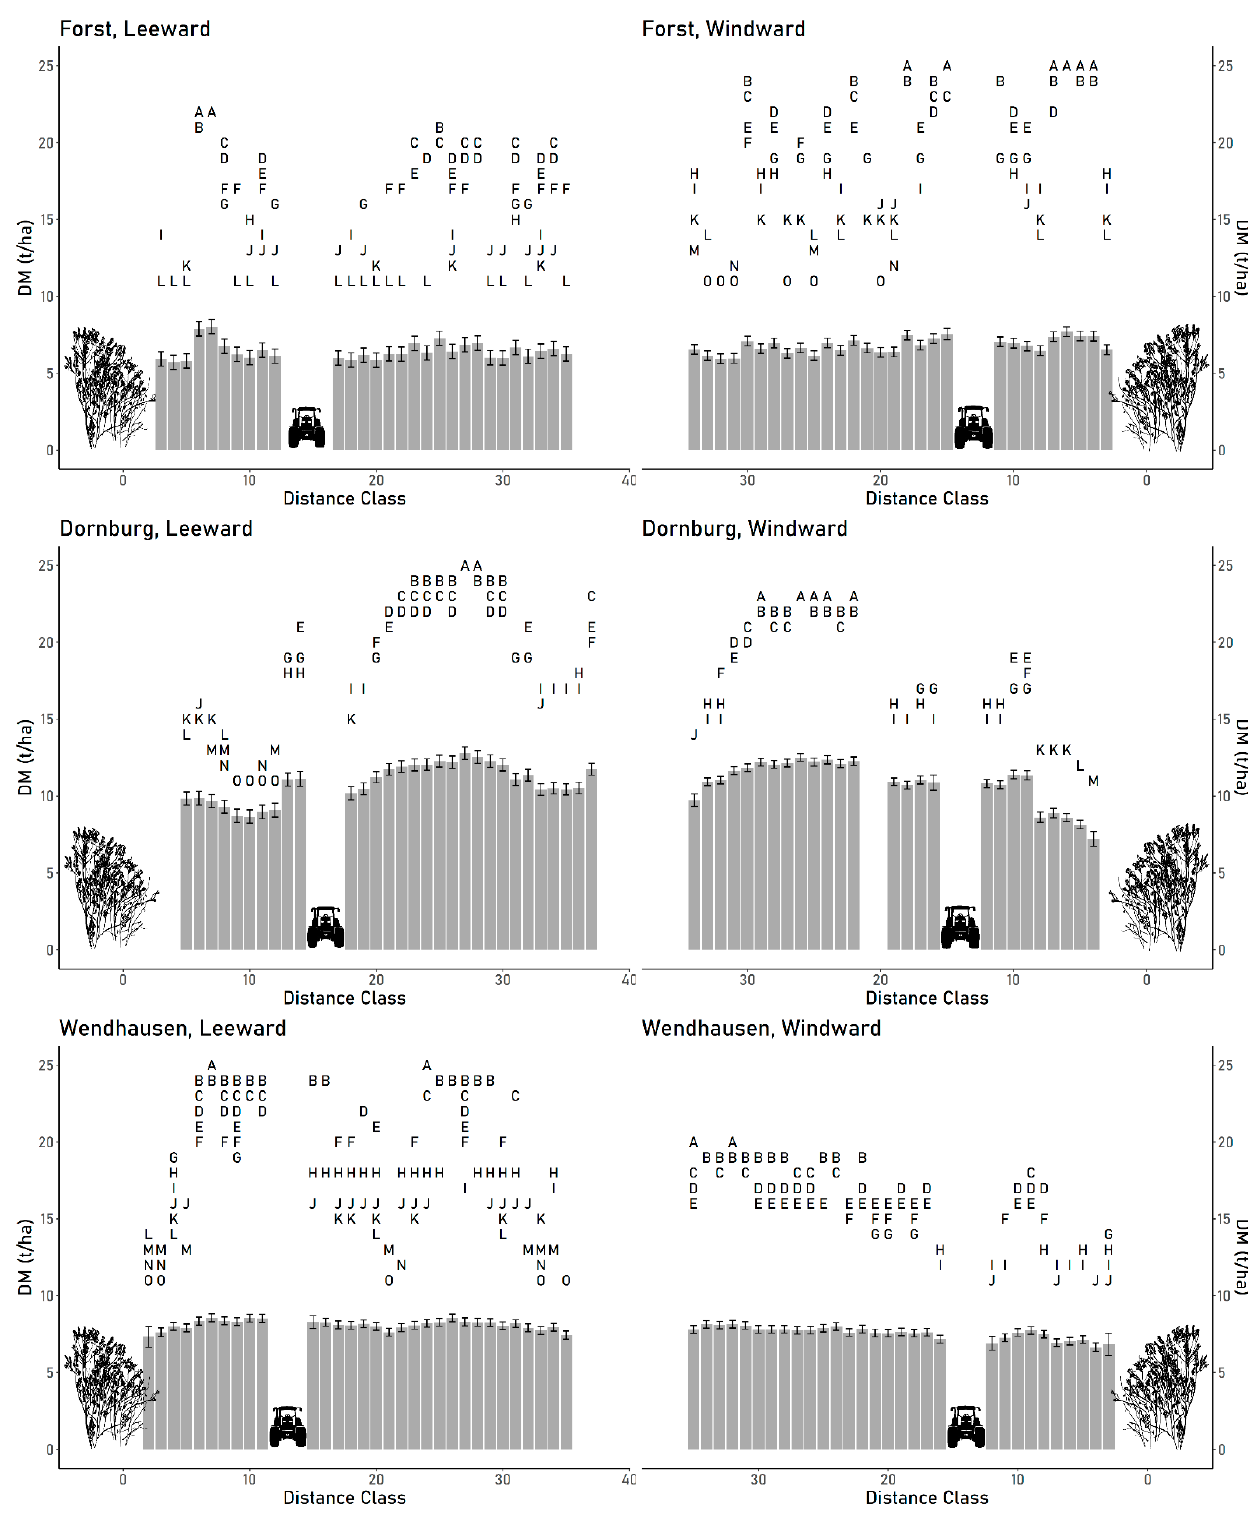
Figure 7. Comparisons of barley total dry matter (DM) least squares means between distance classes. Distance classes for leeward and windward plots are based on real distance to western and eastern tree rows. Distances having no letter in common are significantly different ( α = 0.05). Error bars show 95% confidence limits.